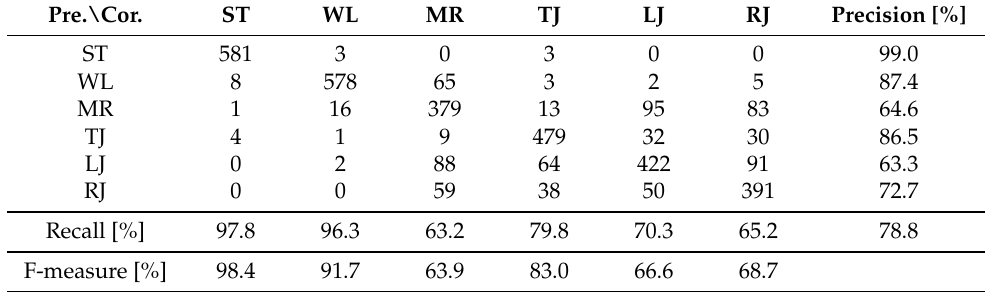
Table 6. Confusion matrix of our method.